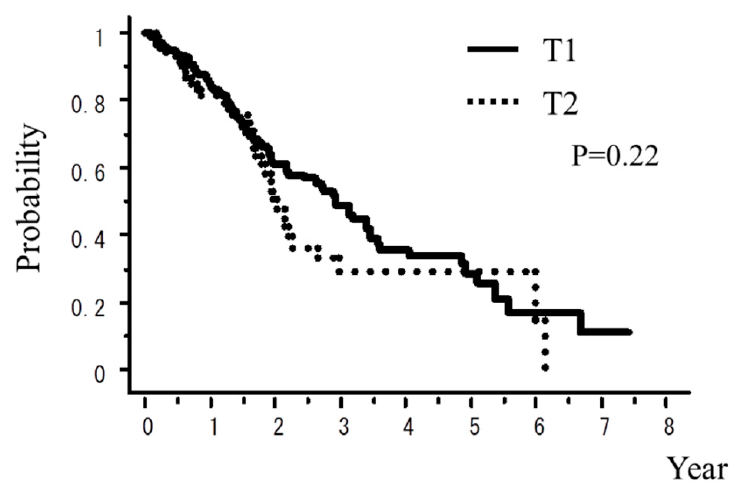
Figure 4. OS rate according to T stage.